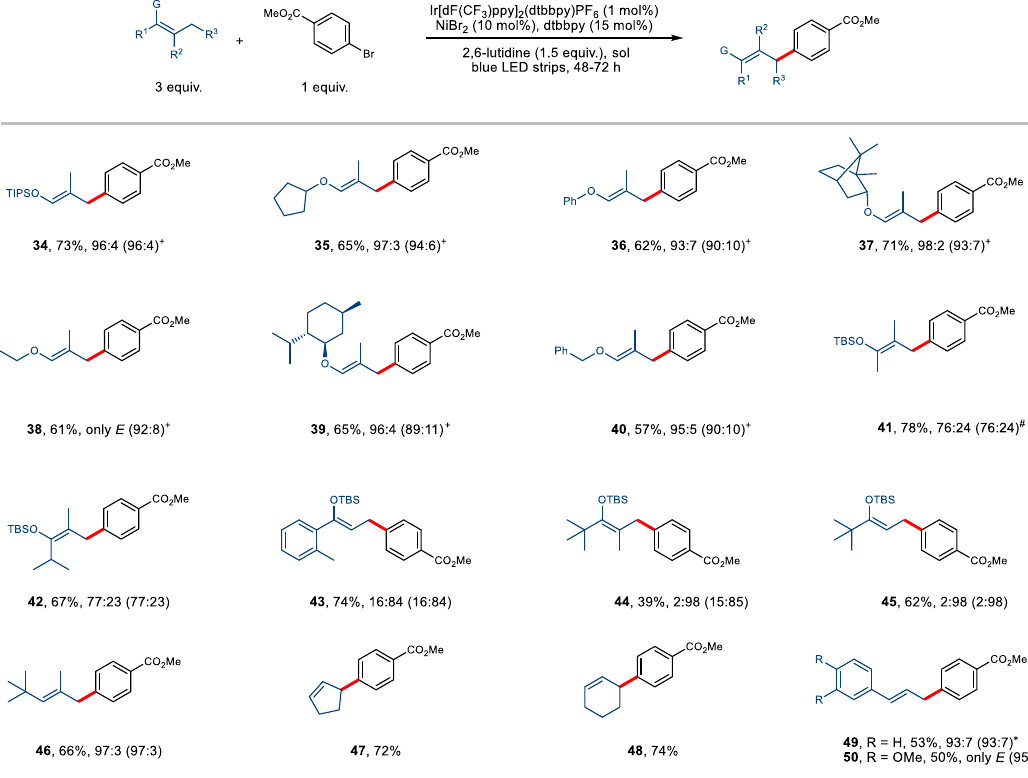
parenthesesreferto E / Z beforepuri fi cation).+ tert -butylacrylate(1equiv.)wasused asadditive.TIPS,triisopropylsilyl.#Formal β -arylationofketonewasachievedafter deprotection. * E / Z before isomerization, 49 (37:63), 50 (33:67), see Supporting Information for reaction condition